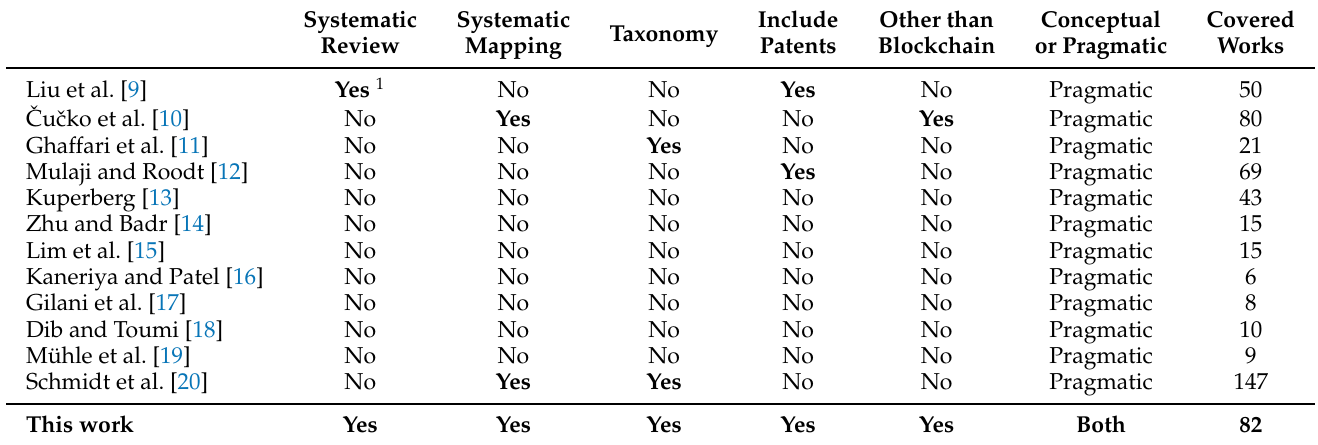
Table 1. Comparison with other secondary studies in the